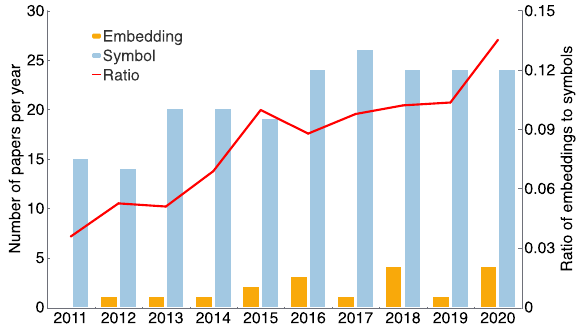
Fig. 17 Number of papers applying symbol-based representation or embedding-based representation and the ratio between them over the last decade in Nature, Science, and PNAS. The line is smoothed by taking a 3-year average. Detailed settings where we selected these papers are shown in Section 7.